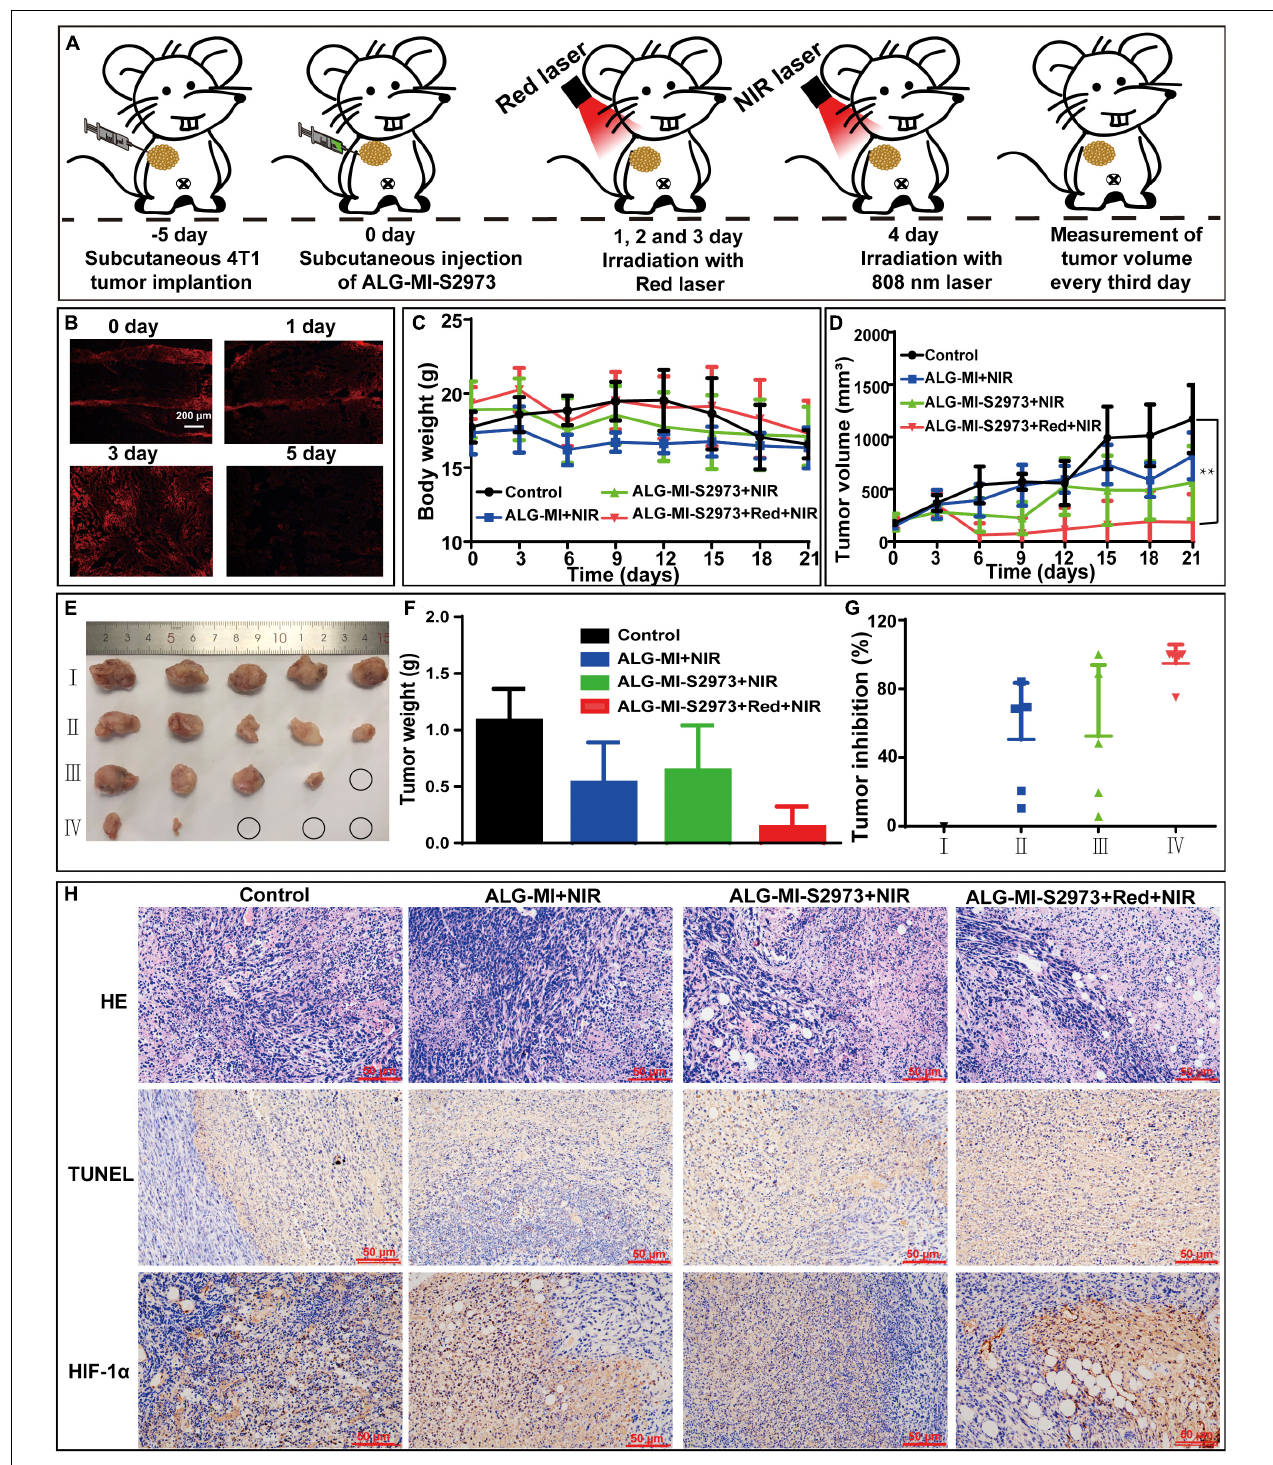
FIGURE 6 | In vivo investigation of anti-tumor effects based on ALG-MI-S2973. Each group contained five mice. (A) Schematic diagram of animal experiments. (B) Viability measurement of S . 2973 in tumor sections using fluorescence imaging excited by 561 nm. (C,D) Body weight changes and tumor growth curves of control and 4T1 tumor-bearing mice with different treatments. ** p < 0.01 compared with untreated group by Student’s t -test. (E,F) Volumes and weight of tumors from 4T1 tumor-bearing mice with different treatments; (G) Tumor inhibition rates of different treatments. (H) H&E, TUNEL and immunohistochemical staining of HIF-1 α protein in tumor tissues from 4T1 tumor-bearing mice with different treatments. ALG-MI, hydrogels packaging MSN-ICG; ALG-MI-S2973, hydrogels packaging MSN-ICG and S . 2973.